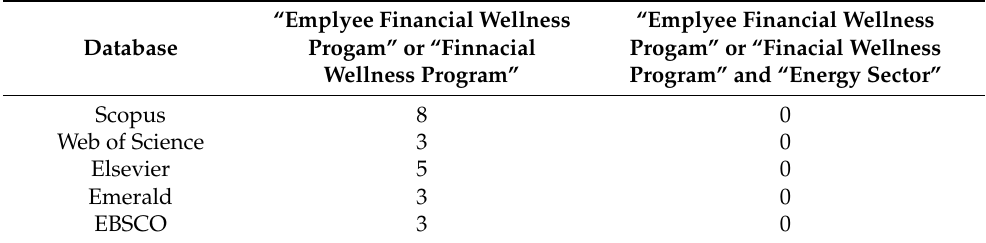
Table 1. Number of articles by search terms and